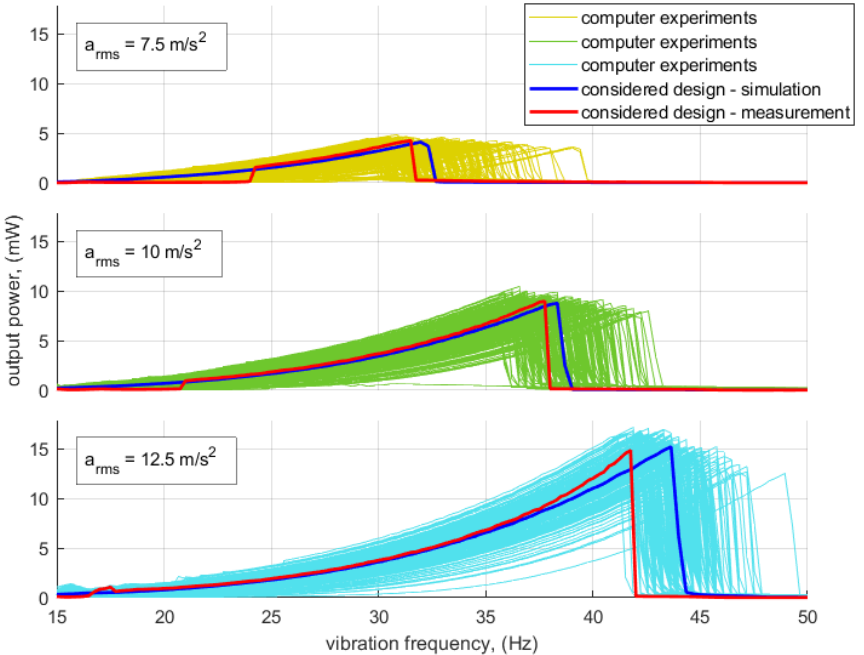
Figure 10. Output power vs. frequency for training points computed from full model for different RMS values of vibration accelerations.